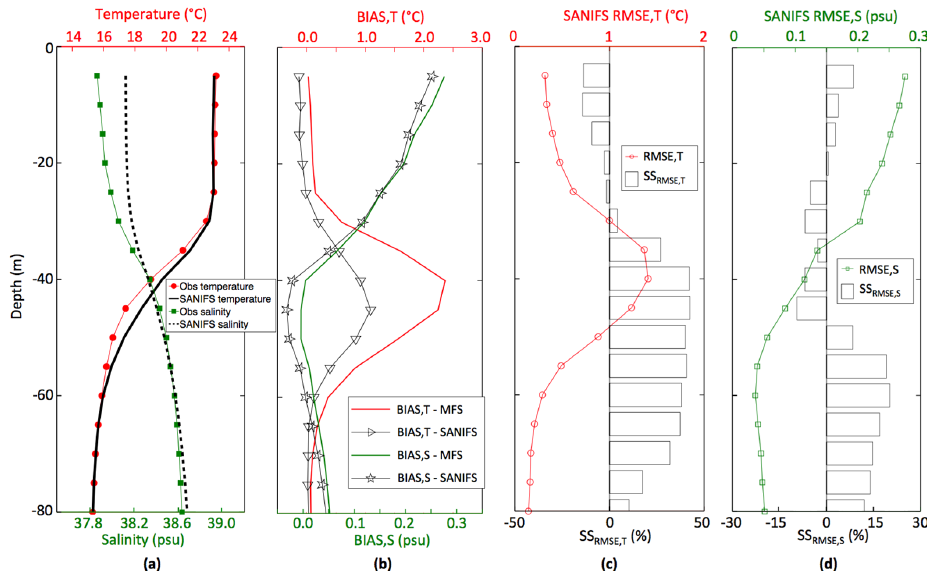
Figure 9. SANIFS average profiles (temperature and salinity) compared with the observed ones for the SCS (a) . Bias with SCS observations of the MFS and SANIFS average profiles (temperature and salinity) (b) . Temperature RMSE for SANIFS (red line with circles) and RMSE skill score compared with reference model MFS for the SCS (c) . Salinity RMSE for SANIFS (green line with squares) and RMSE skill score compared with reference model MFS for the SCS (d) . RMSE skill score is represented by histograms (positive values highlight levels where SANIFS produces more accurate forecasts than MFS; conversely, negative values show the opposite).